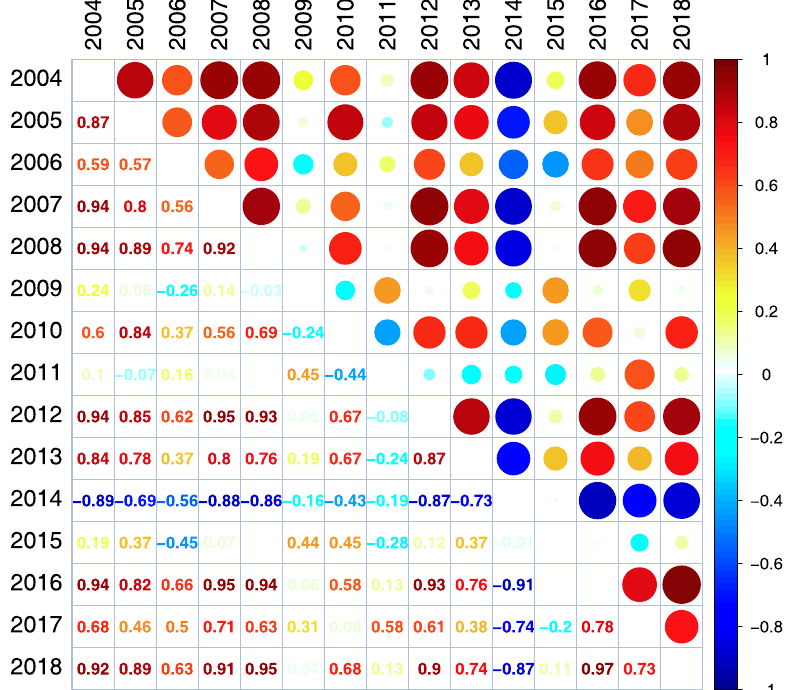
Figure 10. Pearson correlation matrix for time series of detrended groundwater levels corresponding to the summer seasons of the